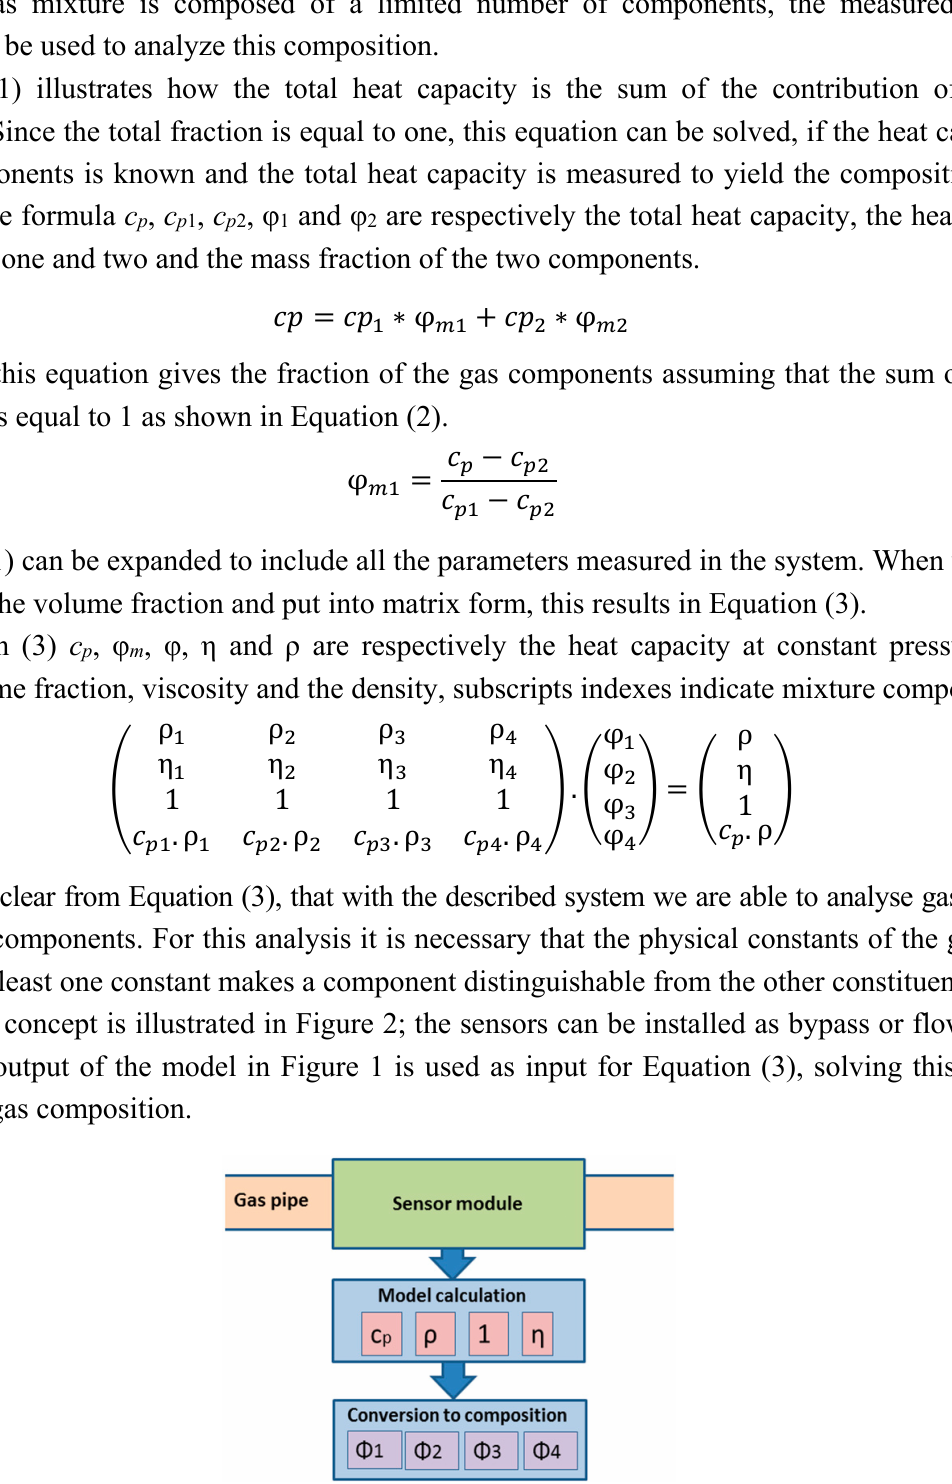
Figure 2. Sketch of the proposed